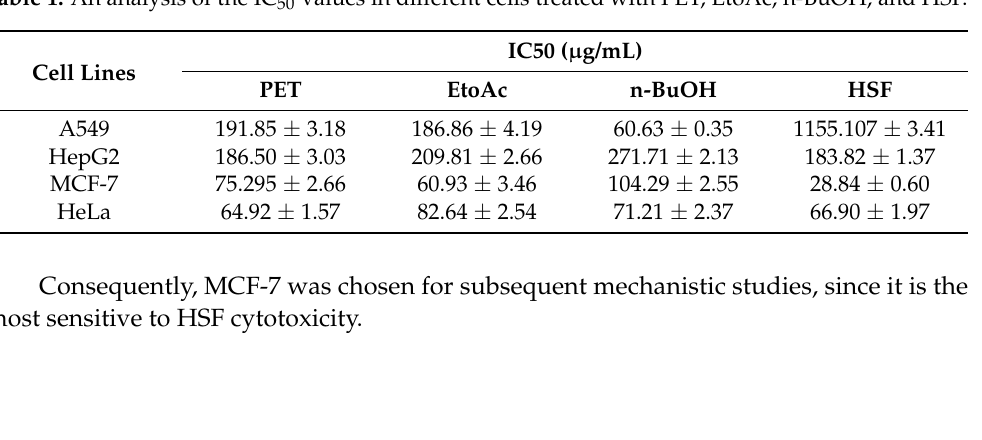
Table 1. An analysis of the IC 50 values in different cells treated with PET, EtoAc, n-BuOH, and HSF. Cell Lines